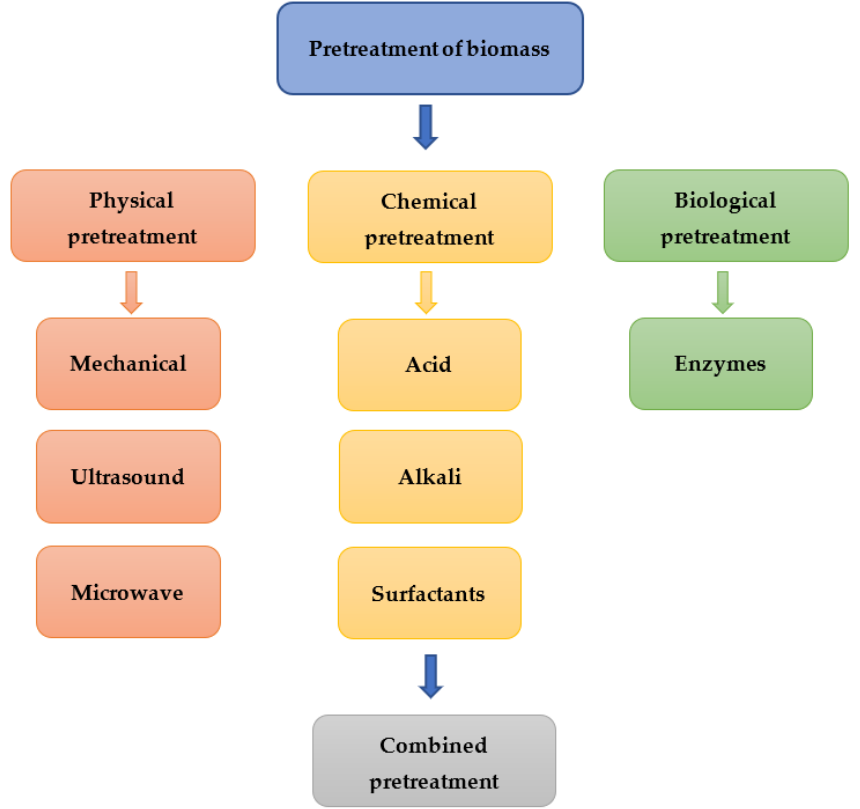
Figure 7. Different types of pretreatment methods.